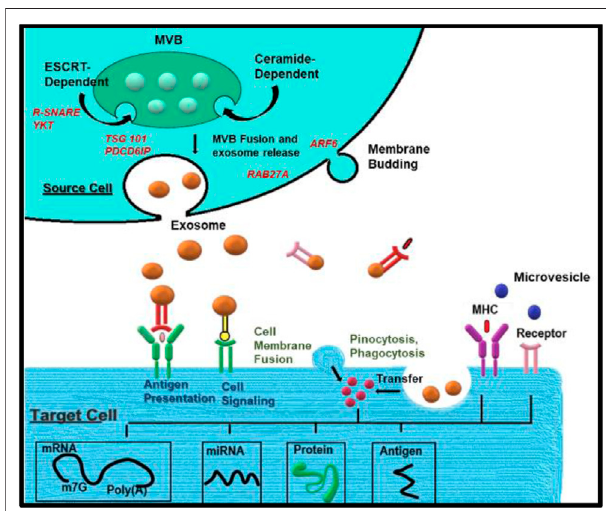
FIGURE 2 | Biogenesis of exosomes: Exosome biogenesis, cargo, and secretion are depicted schematically. Exosomes are generated when the endocytic membrane is invaginated and ILV is created inside the cell. The payloads (RNAs, proteins, and lipids) are integrated into ILV via ESCRT- dependent or ESCRT-independent pathways during maturation, and MVBs are formed by the maturation of early endosomes. MVBs can be sent to lysosomes for breakdown or migrate along microtubules to fuse with the plasma membrane and release exosomes into the extracellular environment. MVB fusion with the cellular membrane is a delicate process that necessitates the presence of numerous key components such as Rab GTPases and SNARE complexes. Endocytosis, direct membrane fusion, and receptor- ligand interaction canall beused totransfer exosomal payloads from asource cell to target